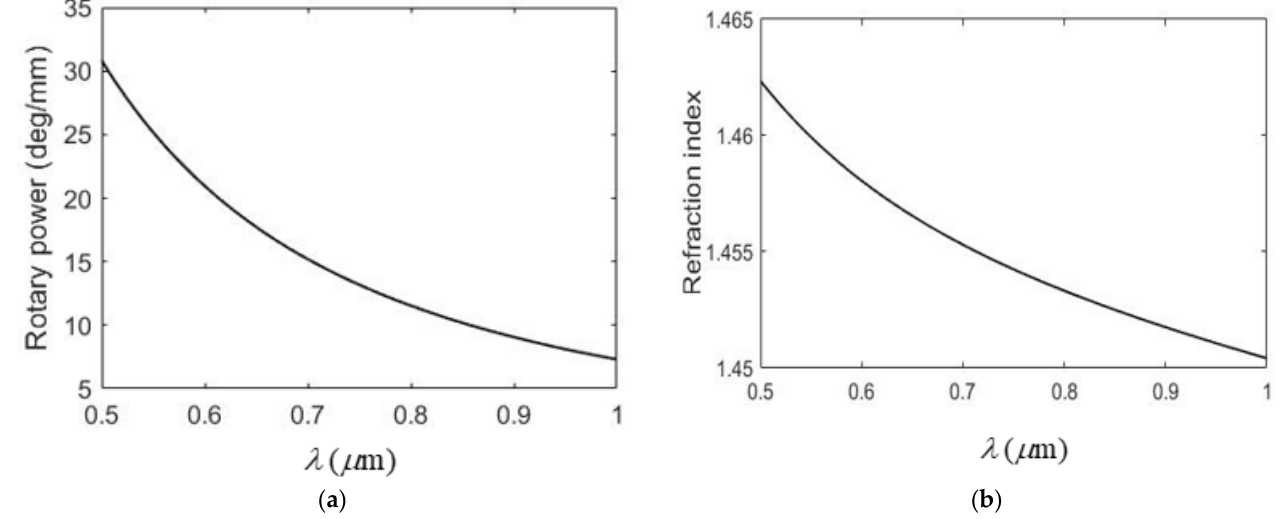
Figure 5. ( a ) The behavior of ρ ( λ ) for quartz. ( b ) The behavior of n ( λ ) for quartz. Consider an incident polychromatic spectrum S in ( λ ) with a flat-top distribution rang- ing from 0.4 µ m to 1.2 µ m, as shown in Figure 6. Here we use S in ( λ ) to differentiate from E in because the latter is for the monochromatic situation and the former is for the poly- chromatic one. The normalization procedure is practiced in Figure 6 because the input intensity can be changed easily. Note that the absorption coefficient of quartz is very low in this spectral range, thus the material absorption can be ignored. Now, because each wavelength component experiences various rotatory power ρ ( λ ) , the final rotation angle φ ( λ ) = ρ ( λ ) · d is also different, as shown schematically in Figure 7. Using the superposi- tion principle and with the help of Equation (5), the output spectrum at each wavelength S out ( λ , θ 2 , φ ) is (cid:110) (cid:111) ) · cos ( θ − φ ( λ ))] 2 + [ sin ( θ ) · cos ( θ − φ ( λ ))] 2 [ cos ( θ S out ( λ , φ ( λ ) , θ 2 ) = S in ( λ ) (7) 2 2 2 2